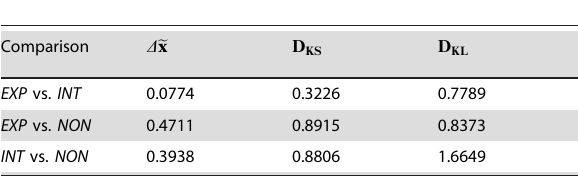
Table 3. Measures comparing cumulative distributions of fraction of aphids moving M % in experiment ( EXP ), a social interaction model ( INT ) and a noninteracting control model ( NON ). Comparison D e